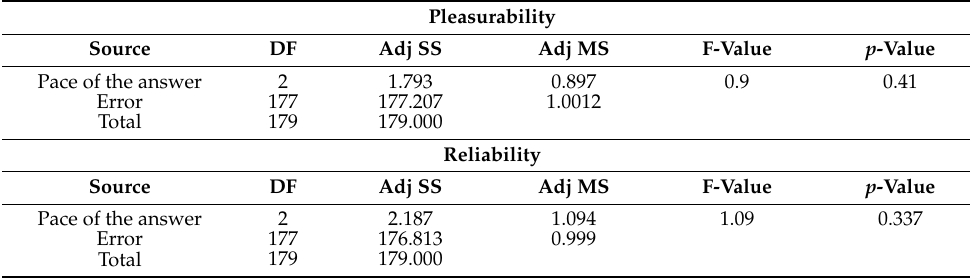
Table A3. One-way ANOVA for “Pace of the answer”.